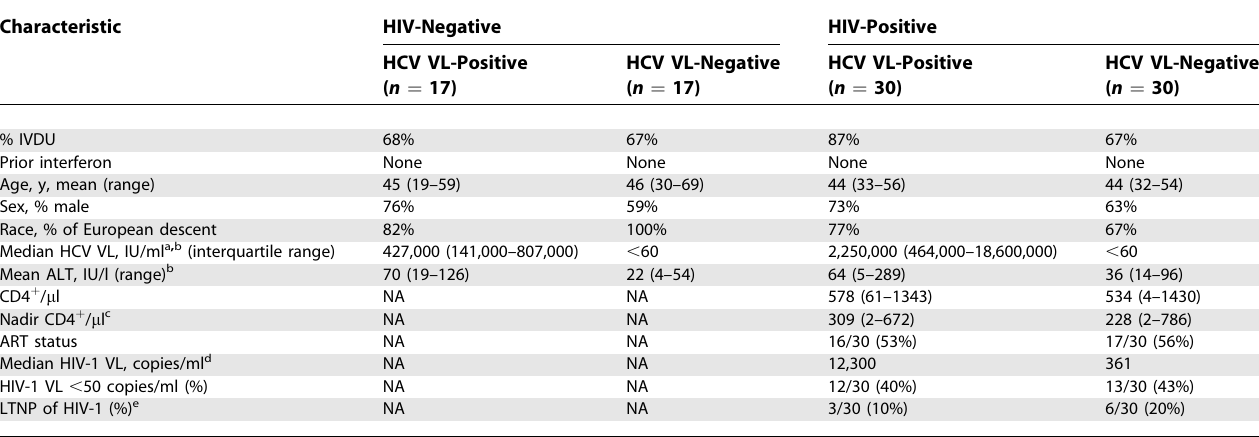
Table 1. Characteristics of 94 HCV-Infected Patients Characteristic